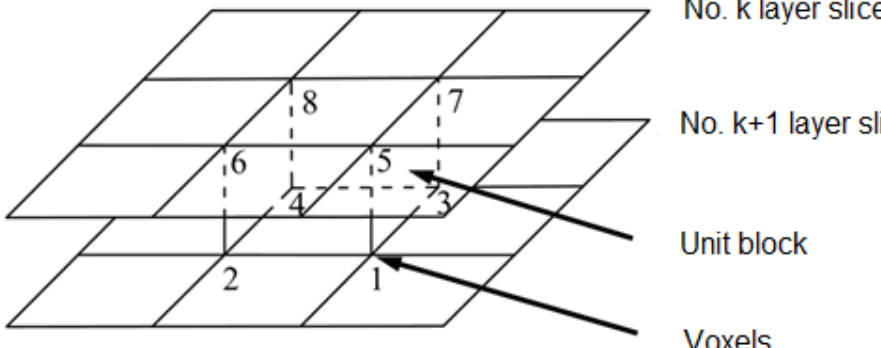
Figure 7. Schematic diagram of unit block and voxels.